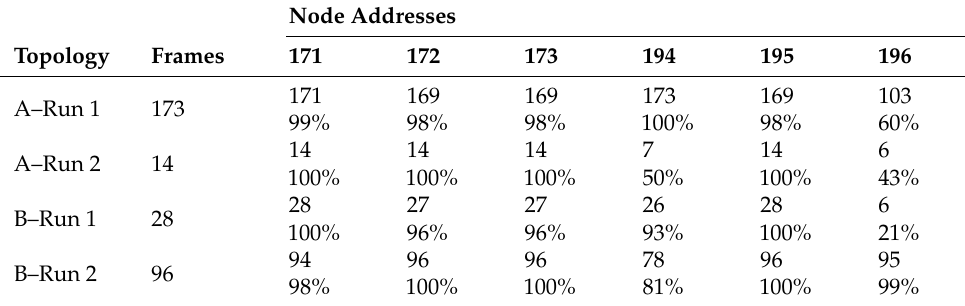
Table 4. End-to-end packet delivery statistics at the gateway node.